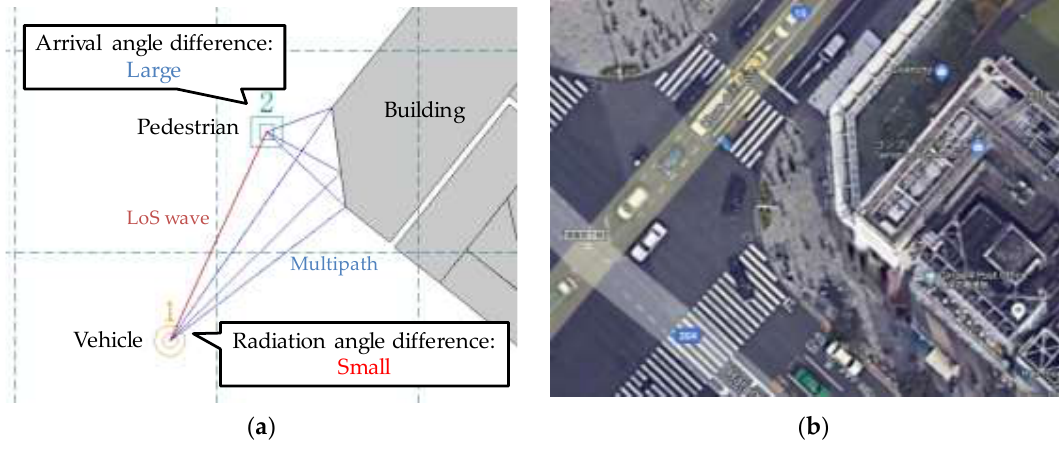
Figure 10. Signal propagation from a vehicle to a pedestrian. ( a ) Radiation and arrival angles of multipath waves combined with a LoS wave. ( b ) The aerial photograph of the same location (acquired by Google Earth).